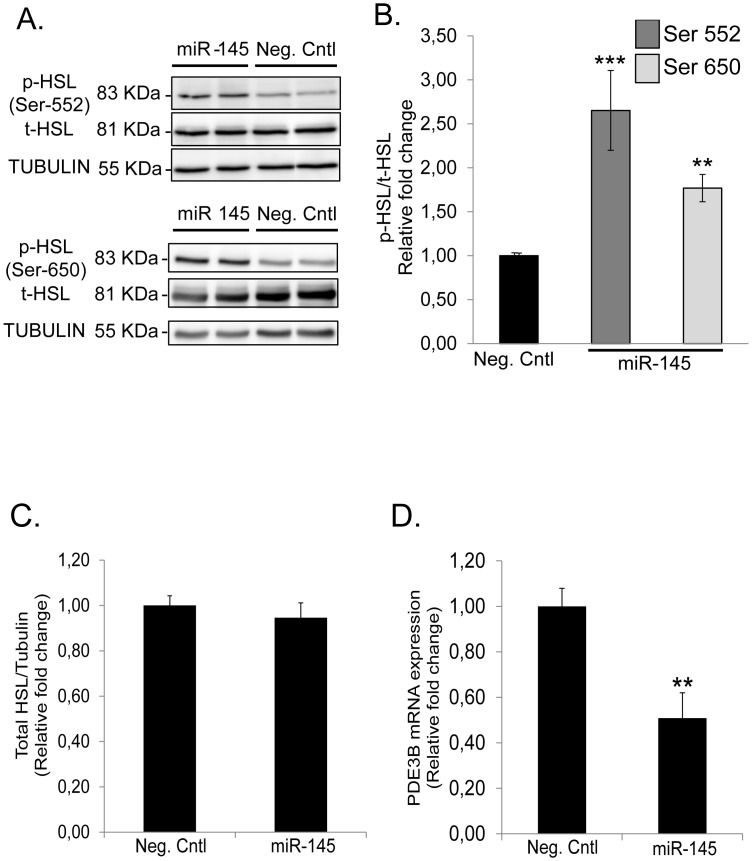
miR-145 increases HSL phosphorylation at activating residues (but does not change total protein content of HSL) and down-regulates PDE3B.(A) Representative blots of protein expression levels of phosphorylated HSL (Ser-552 and Ser-650) and total HSL in human differentiated adipocytes transfected with miR-145 mimics for 48 h. (B) Relative quantification by densitometry of above depicted blots for p-HSL (Ser-552, dark grey; Ser-650, light grey) and (C) total HSL. Equal amounts of total protein were loaded and separated by SDS-PAGE as indicated in experimental procedures. Total HSL levels were corrected by tubulin expression and p-HSL levels were corrected by total HSL protein content. Values are shown as mean of pooling results from three biological/independent experiments. (D) Relative expression of PDE3B after miR-145 over-expression in human differentiated adipocytes for 48 h. Results are representative of four biological/independent experiments. Values are shown as mean ± SEM. Statistical differences (vs. Neg. Cntl) were analyzed by Student t-test: **p<0.01; ***p<0.001.